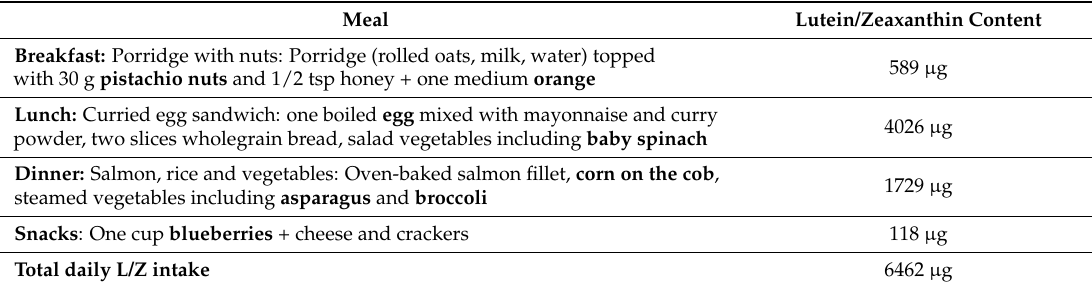
Table 6. Example meal plan with calculated L/Z content >5 mg.